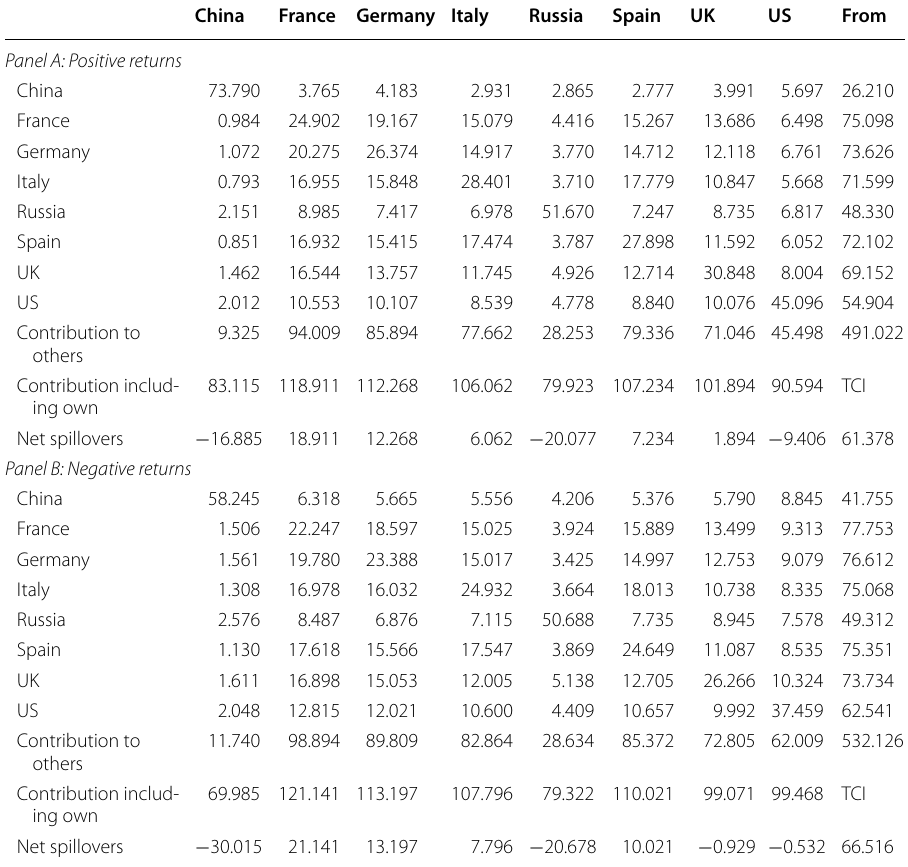
Table 3 Dynamic asymmetric connectedness table